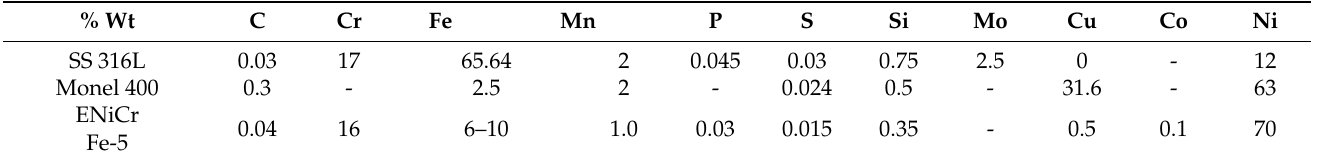
Table 1. Chemical